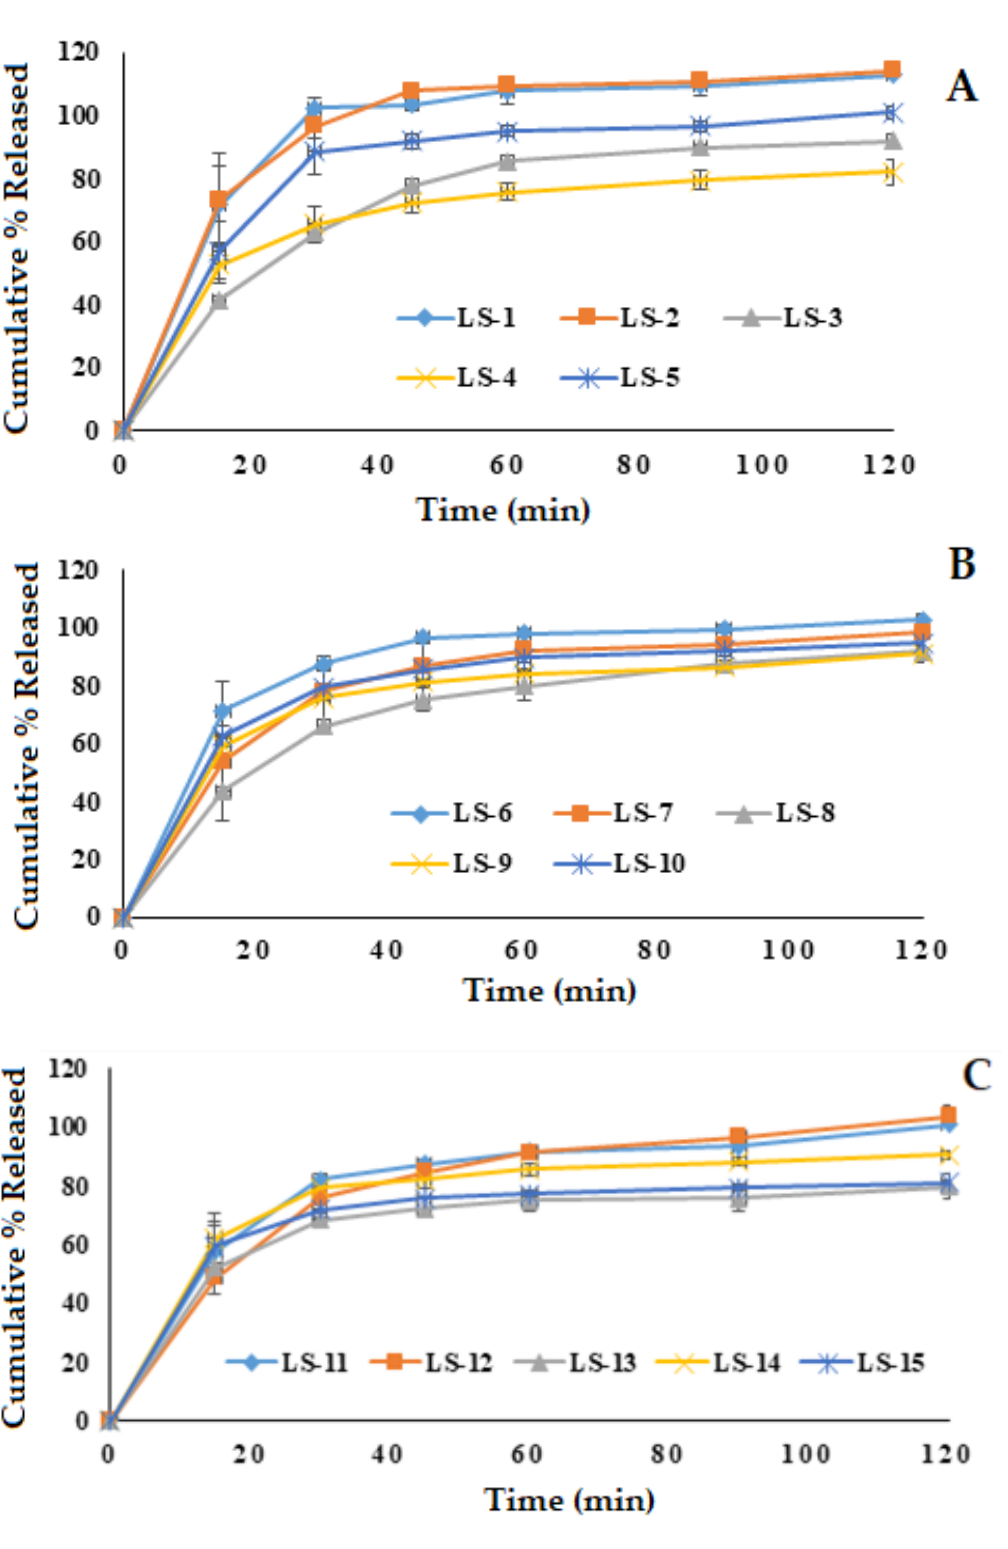
Figure 3. In vitro release of glimepiride from the prepared fifteen liquisolid tablet formulations. ( A ); LS-1: LS-5, ( B ); LS-6: LS-10, ( C ); LS-11: LS-15.